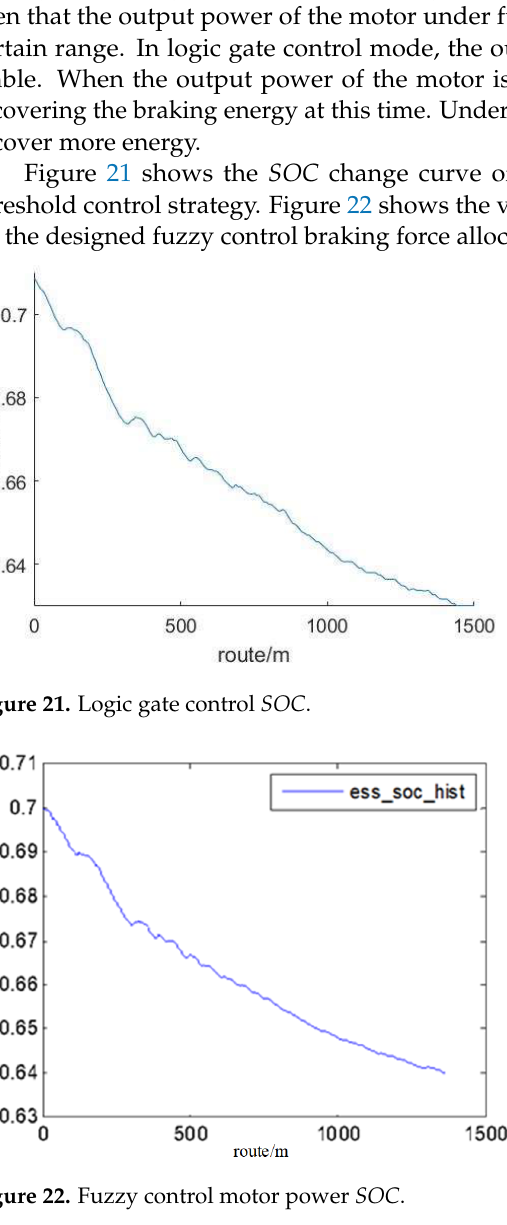
Figure 20. Fuzzy control motor power.